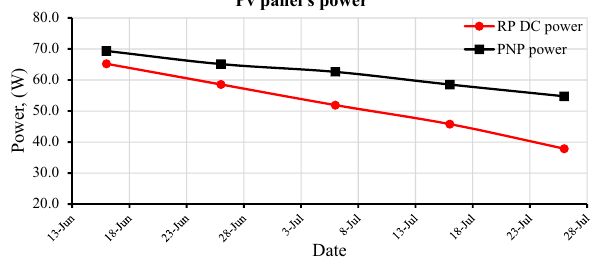
Figure 13. The degradation in the RP and PNP power within 40 days.